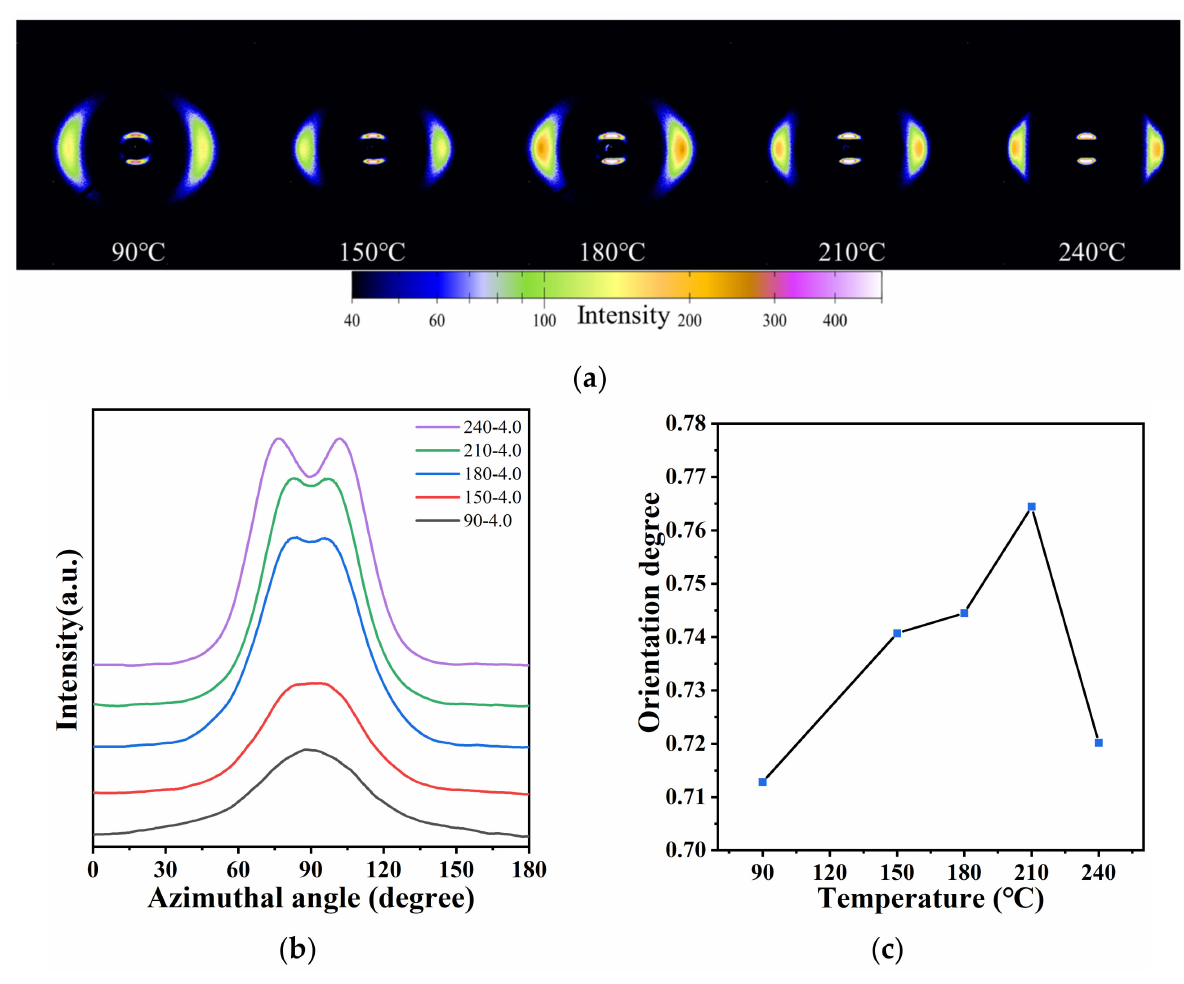
Figure 6. ( a ) 2D-WAXD diffraction patterns of PA12T films at different stretching temperatures; ( b ) azimuthal distribution of PA12T films at different stretching temperatures; ( c ) relationship between crystal orientation degree and stretching temperature.